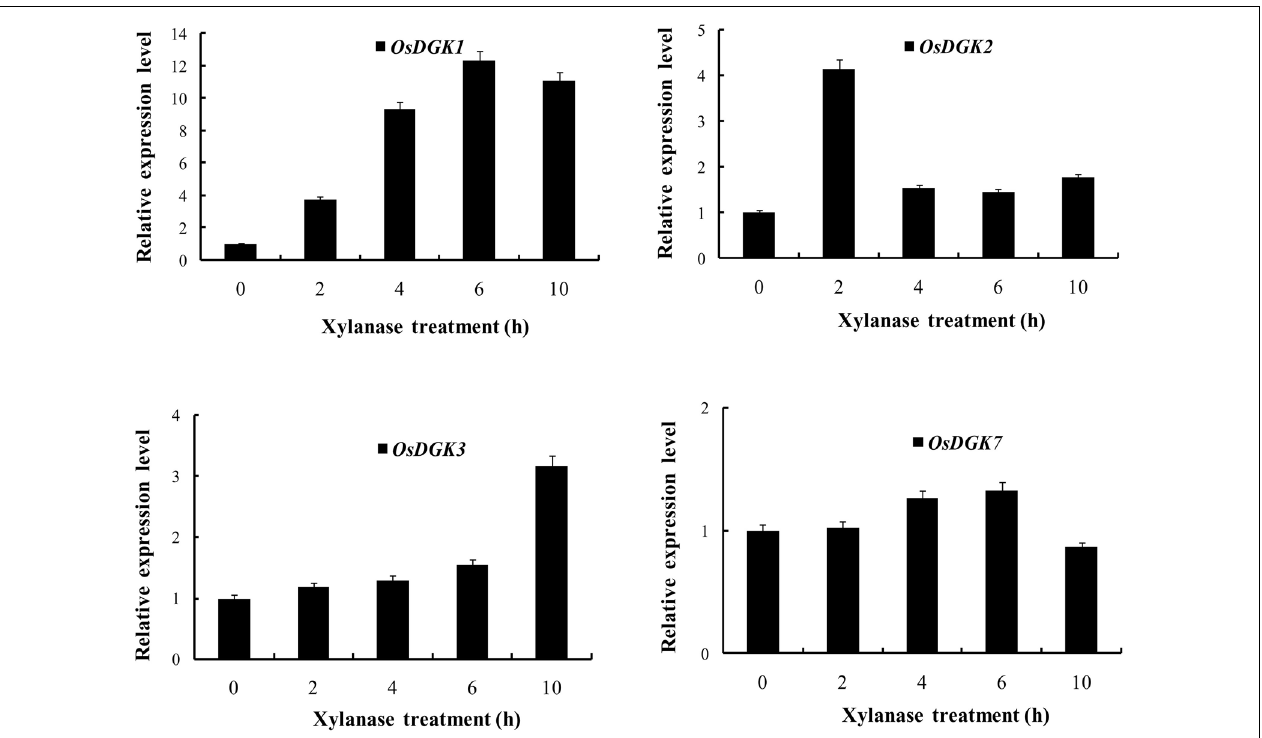
FIGURE 4 | Real-time PCR analysis of the expression of OsDGK ( 1 , 2 , 3 , 7 ). Rice protoplasts were treated with 150 μ g/ml xylanase.The transcripts of four OsDGK genes were monitored with real-time PCR.The data shown are averages of three replicates, each with three PCR samples from the same cDNA